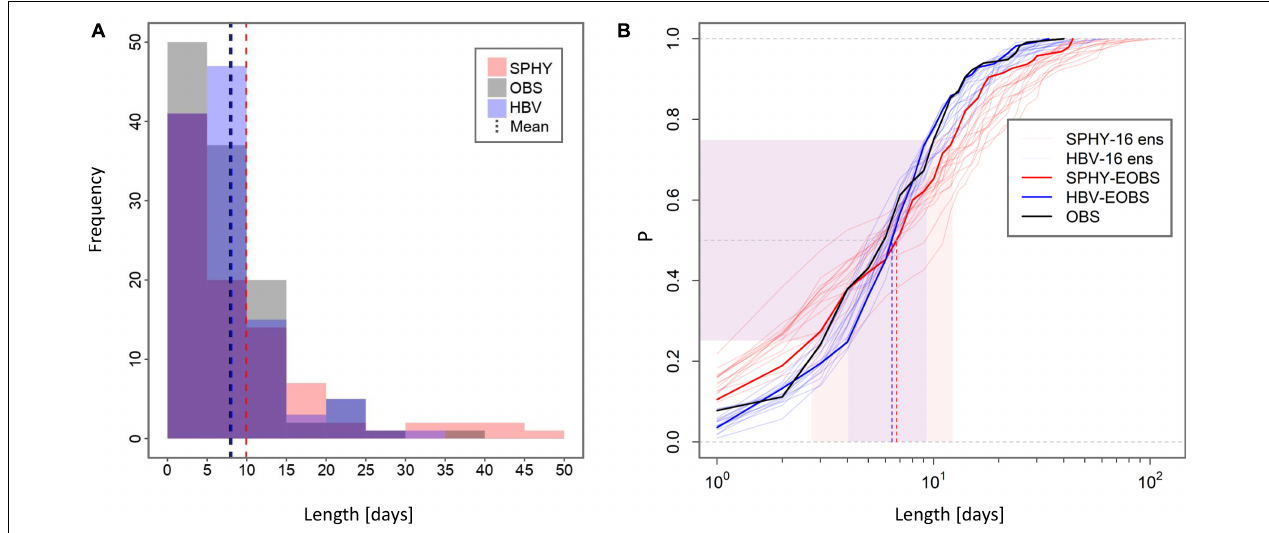
including intensity, duration and frequency of precipitation, soil moisture, the existence of basal flow (e.g., due to snow/ice melt upstream), river bathymetry and topography. Modeling and representation errors in each of these processes can explain part of the large difference in observed and modeled peak- flow days.